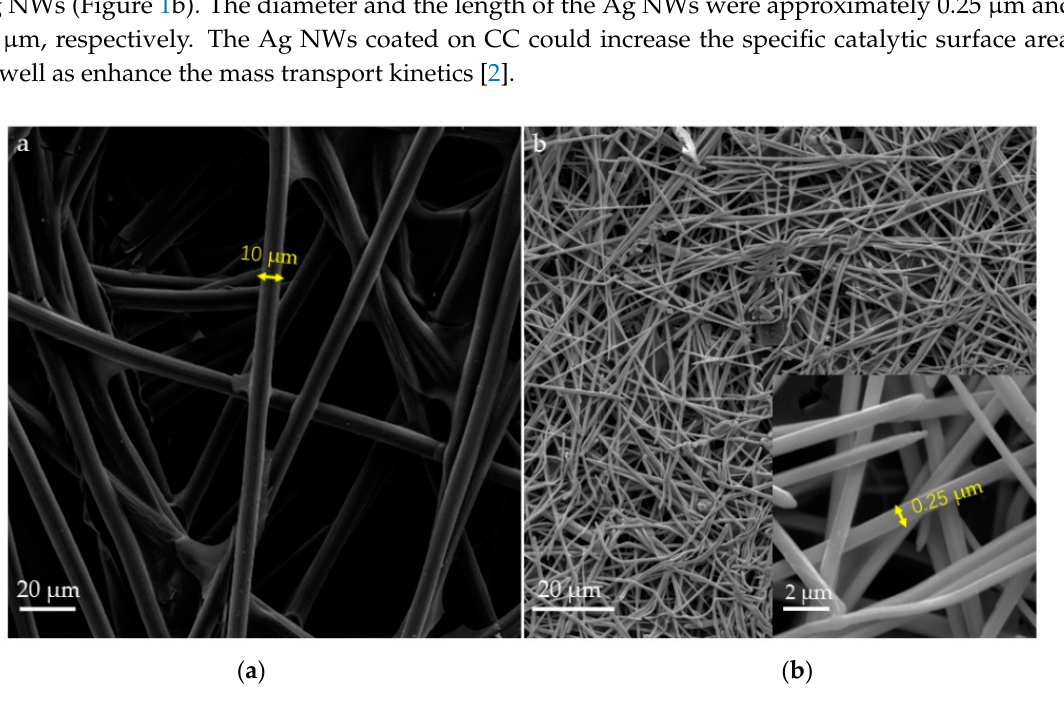
Figure 1. Scanning electron microscope (SEM) image of carbon paper (CC) ( a ) and silver nanowire (Ag NW)//CC ( b ). The inset image indicates the magnified morphology of Ag NWs.